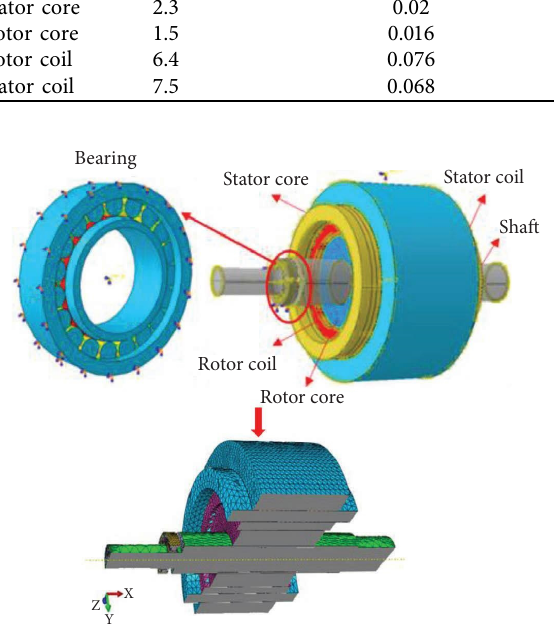
Figure 5: Termal-mechanical coupled model of traction motor bearing considering other parts of the traction